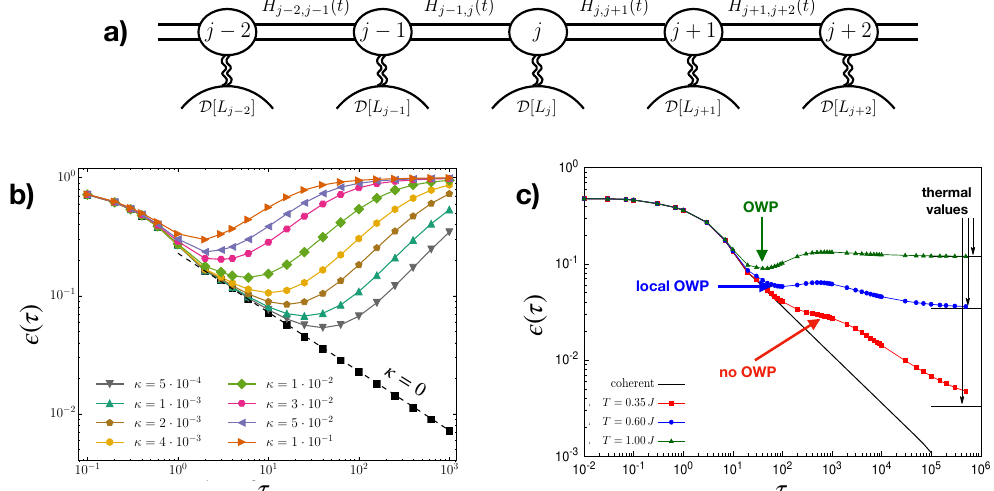
Figure 1. ( a ) Setup for QA protocols. The various sites interact through time-varying Hamiltonian terms H j , j + 1 ( t ) , and are locally coupled to independent reservoirs. ( b , c ) Excess energy as a function of the annealing time τ , for a quantum Ising chain locally coupled to: ( b ) a bath inducing incoherent decay mechanisms; ( c ) an Ohmic bath of quantum harmonic oscillators at different temperature T